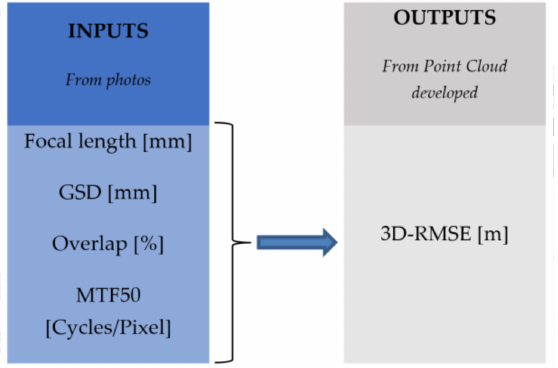
Figure 6. Artificial neural network